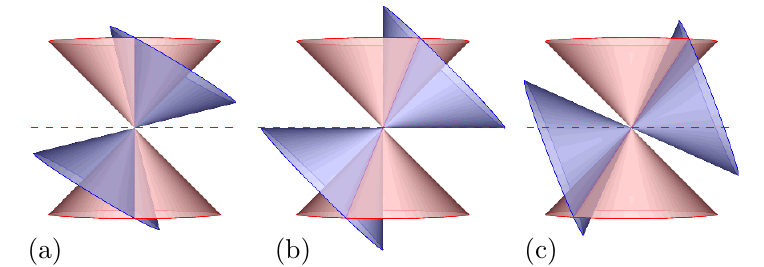
Figure 6 . Good and bad coordinate